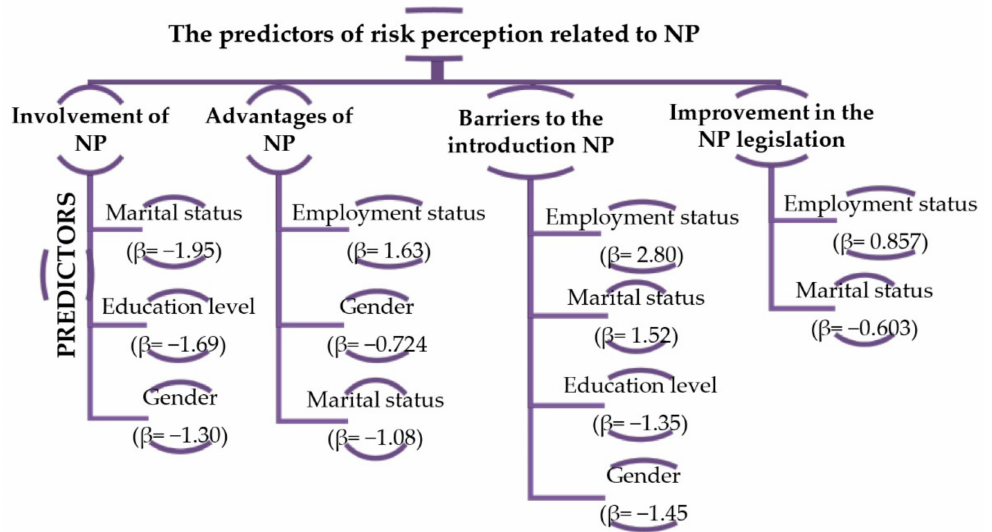
Figure 3. The predictors of risk perception related to nuclear